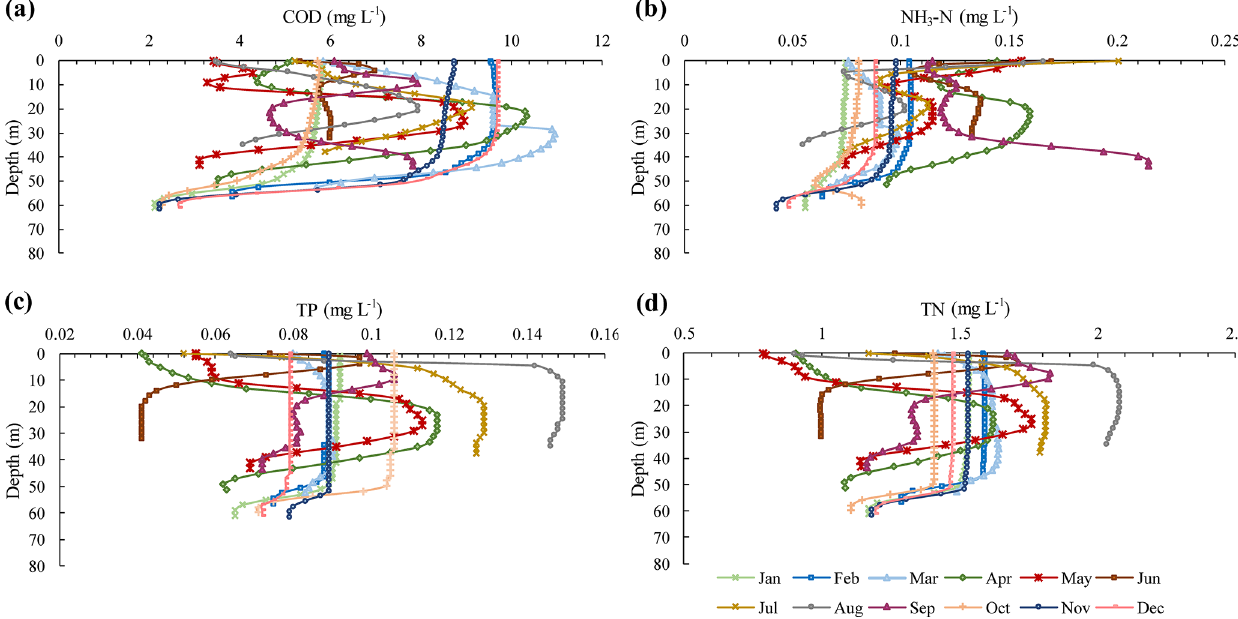
Figure 16. Vertical variation in the water quality in different months at the section that was 6km away from the confluence. (a) Variation in chemical oxygen demand; (b) variation in ammonia nitrogen; (c) variation in total phosphorus; and (d) variation in total nitrogen.